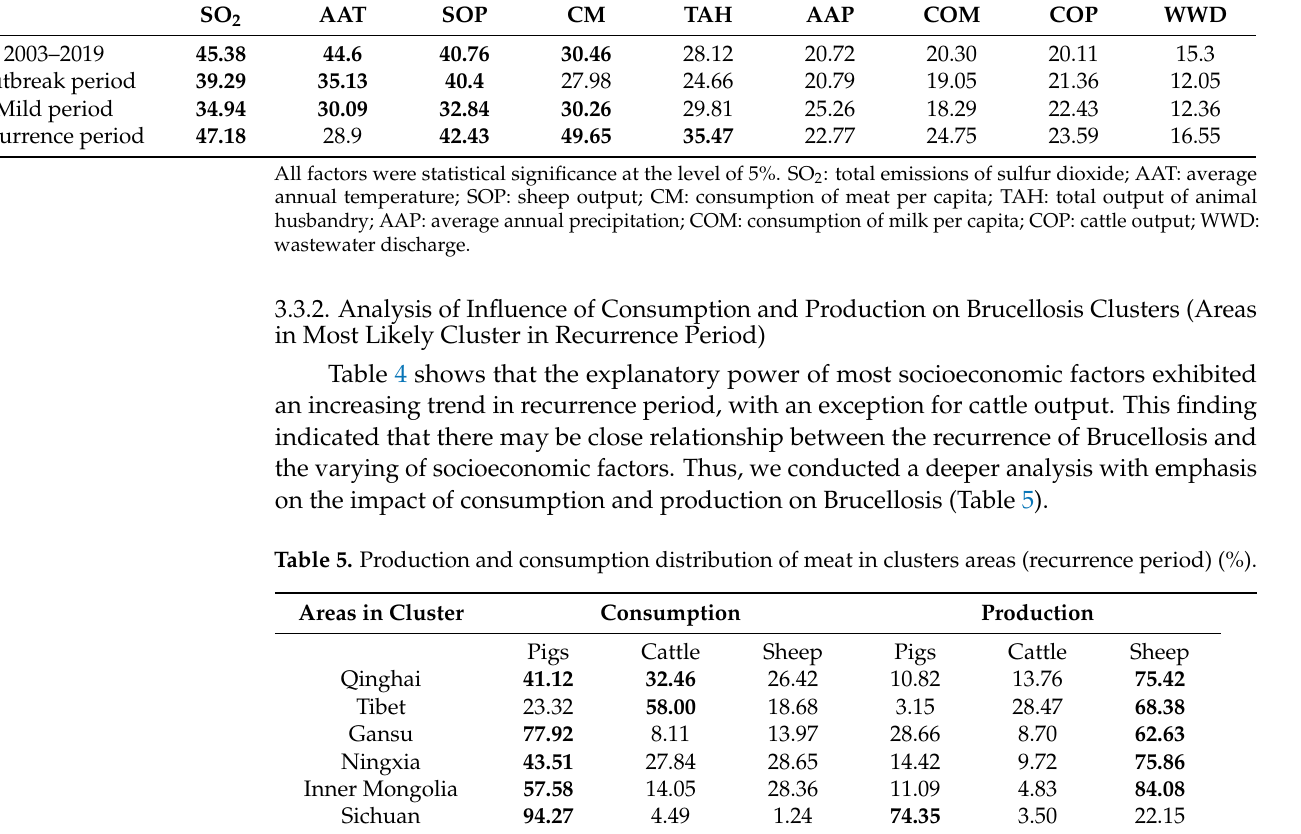
Table 5 showed that: (1) The consumption of pigs and cattle dominated